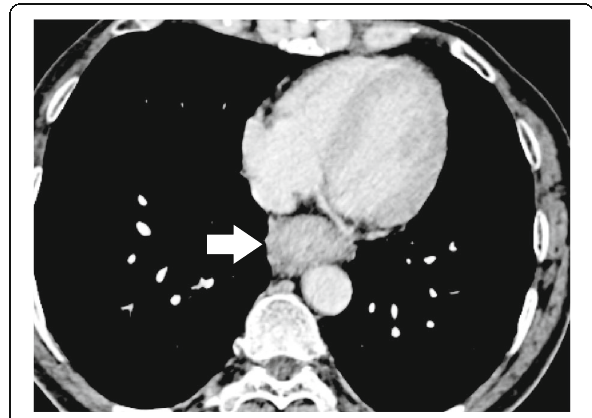
Fig. 1 CT image before treatment. Wall thickness of the lower thoracic esophagus (white